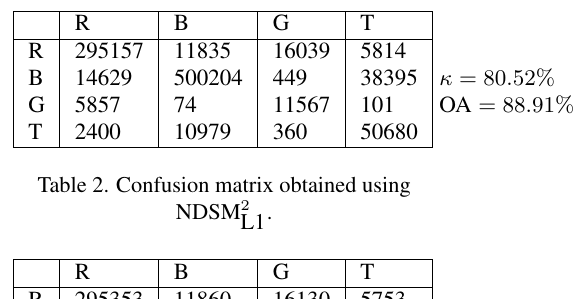
Figure 12. Orthophoto (top left), reference data (bottom left), NDSM (top right) and final result based on Random Forest (bottom right). Figure 13. Detailed views of classification results (top row) in areas of bridges (I,II) mixture of parking slot and lawn (III): (middle and left) bridges densely-classified as buildings, incorrectly classified grass and tree areas (right); corresponding orthophotos (middle row); ground truth data for areas I-III (bottom row).